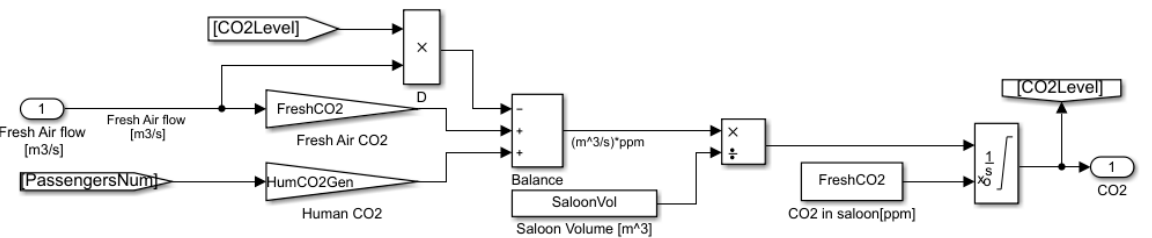
Figure 6. Model of the CO 2 signal.